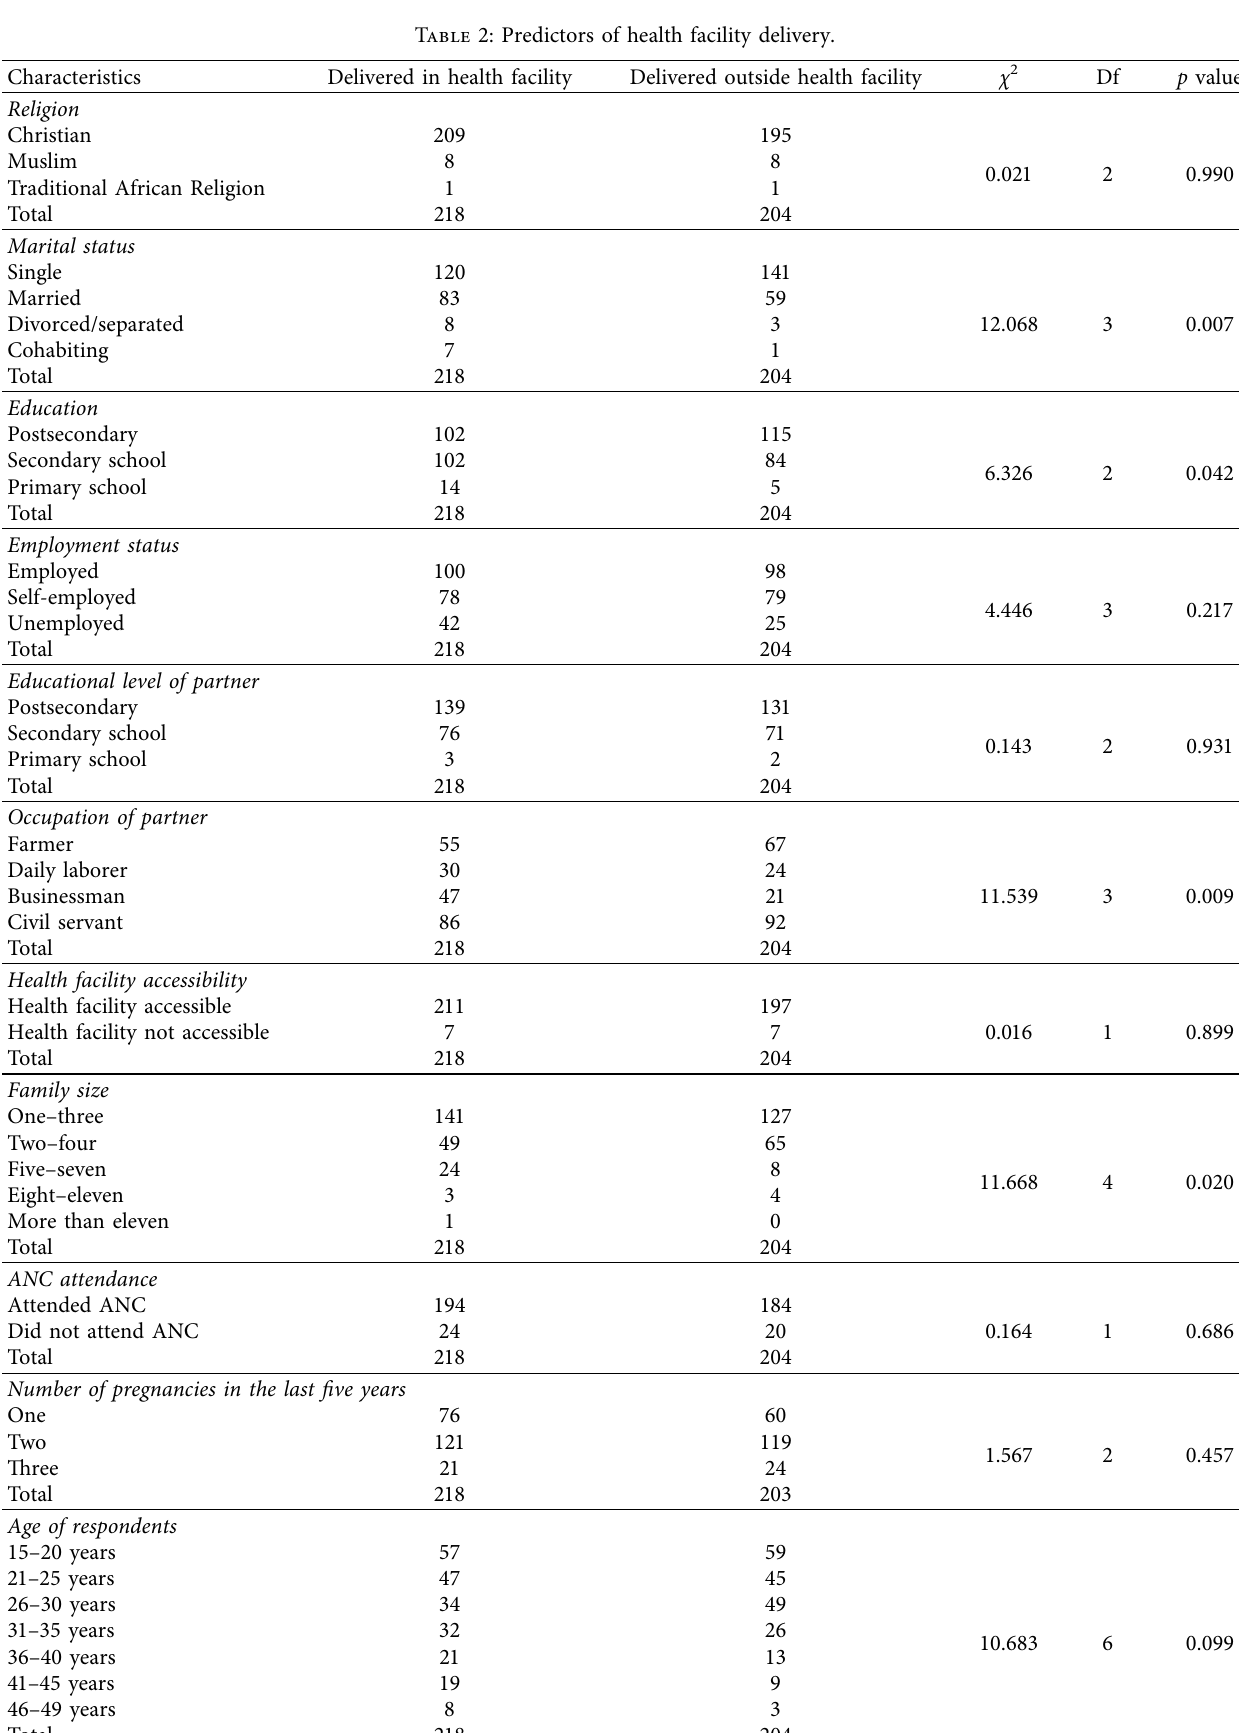
Table 2: Predictors of health facility